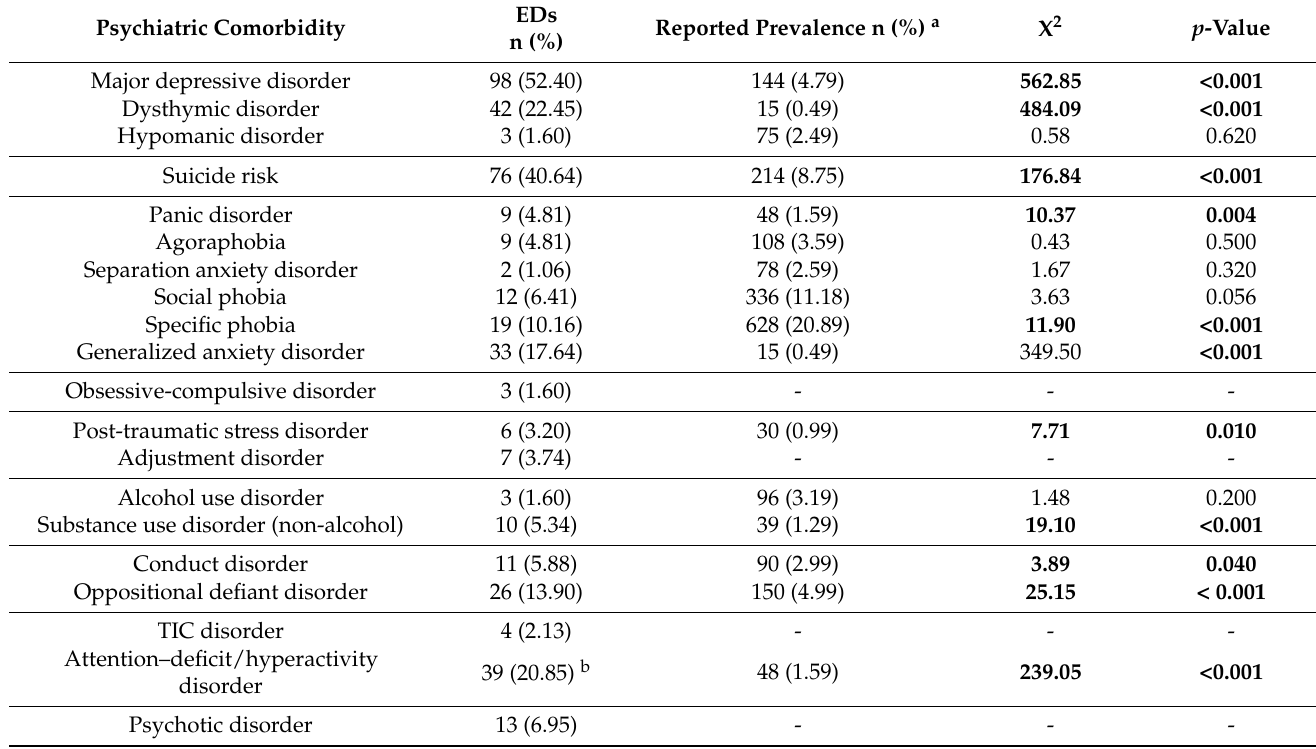
Table 1. Comparison of psychiatric comorbidity prevalence in patients with eating disorders and reported prevalence in the Mexican adolescent